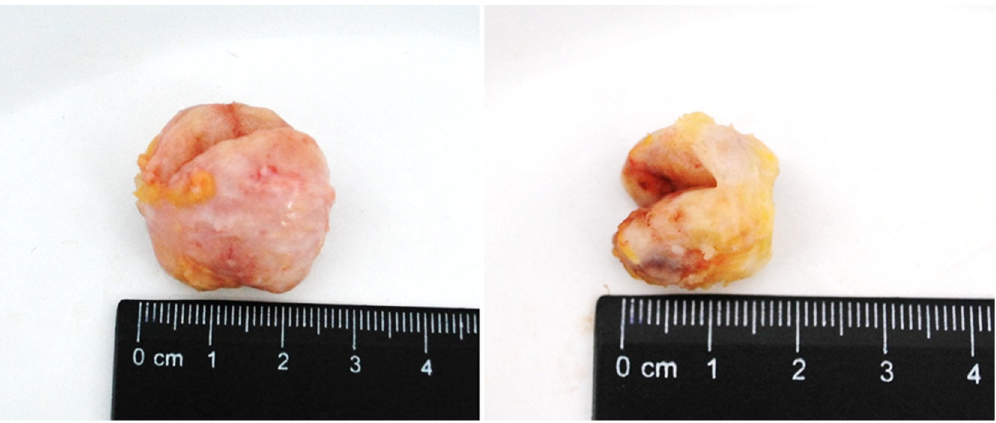
Figure 2. BBT (fibroadenoma) of the breast in section.